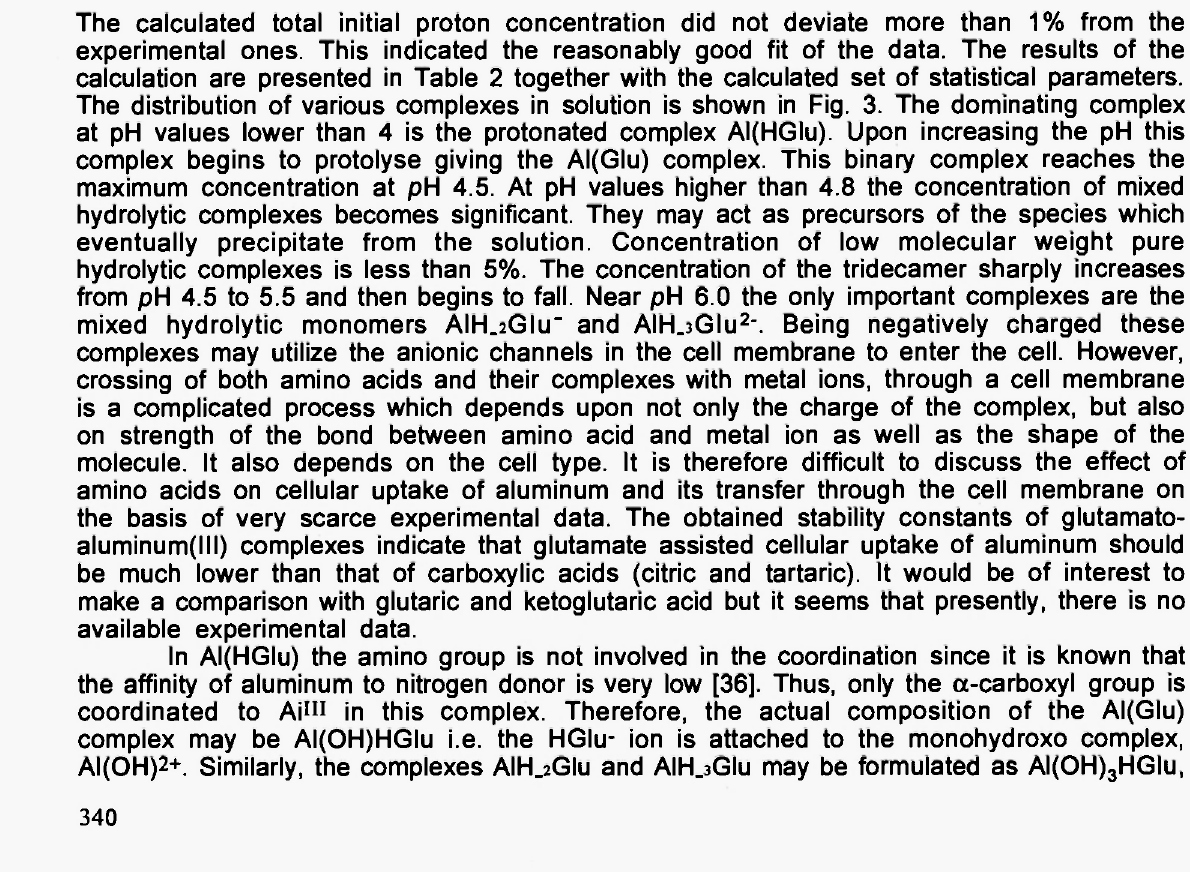
FIG. 2. Formation curves in L-glutamic acid + Al m system, in 0.1 mol/dm 3 LiCI medium at 298 Κ. Concentration ratio [Glu]: [Al] = 5: